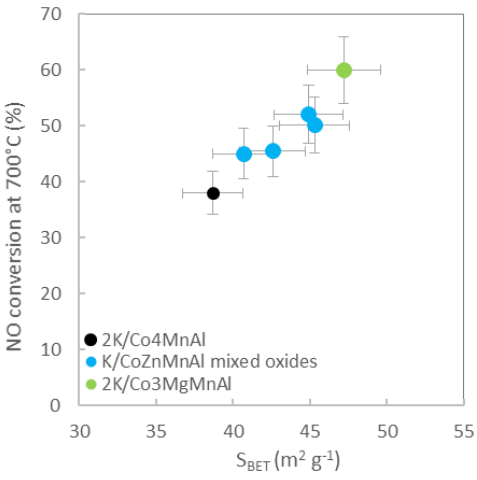
Figure 11. Dependence of NO conversion on the specific surface area. The higher specific surface area allowed for the accessibility of a higher number of active sites. The achieved NO conversion was found to be higher with a more adsorbed loosely bound mononitrosyl species of NO (the NO peak area of the III. peak in TPD-NO) and also with the surface nitrate (the NO peak area of the IV. peak in TPD-NO) (Figure 12).